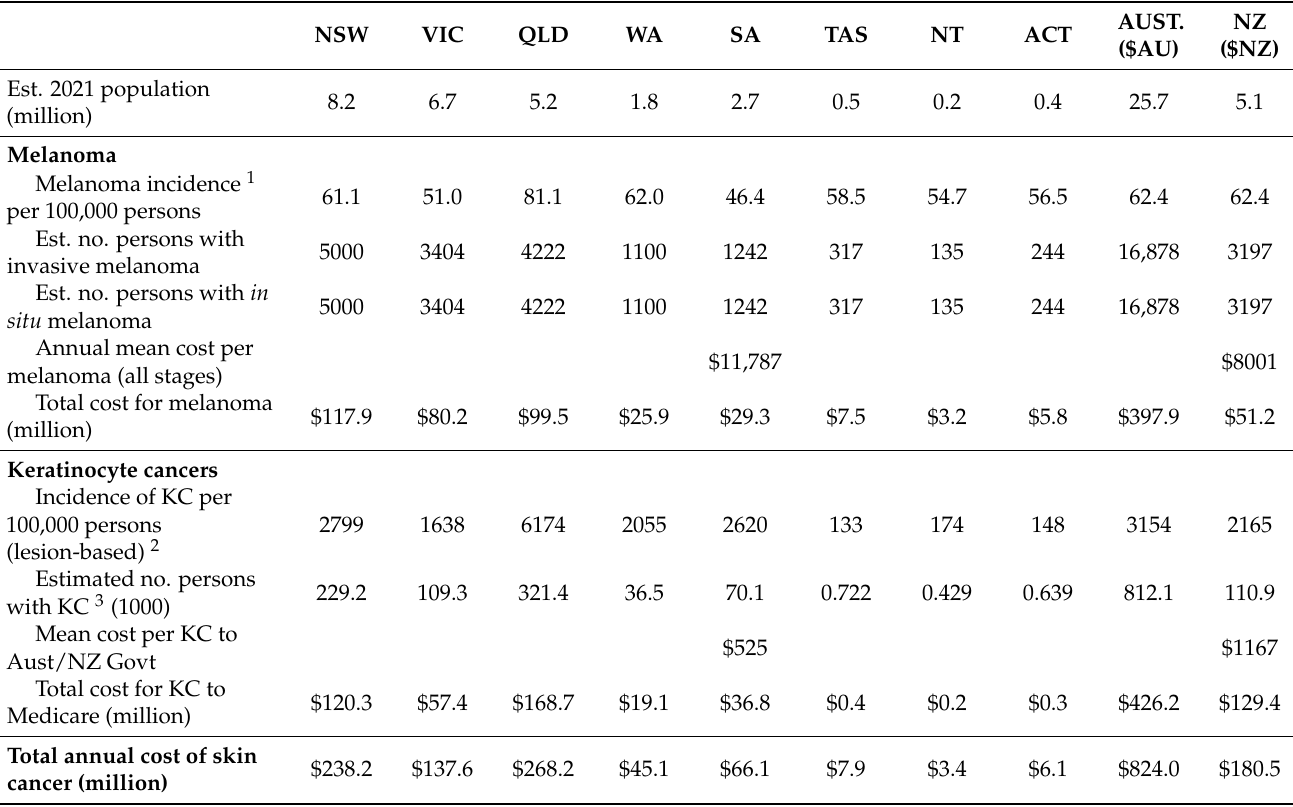
Table 1. Estimated costs of new persons with skin cancers in Australia and New Zealand,